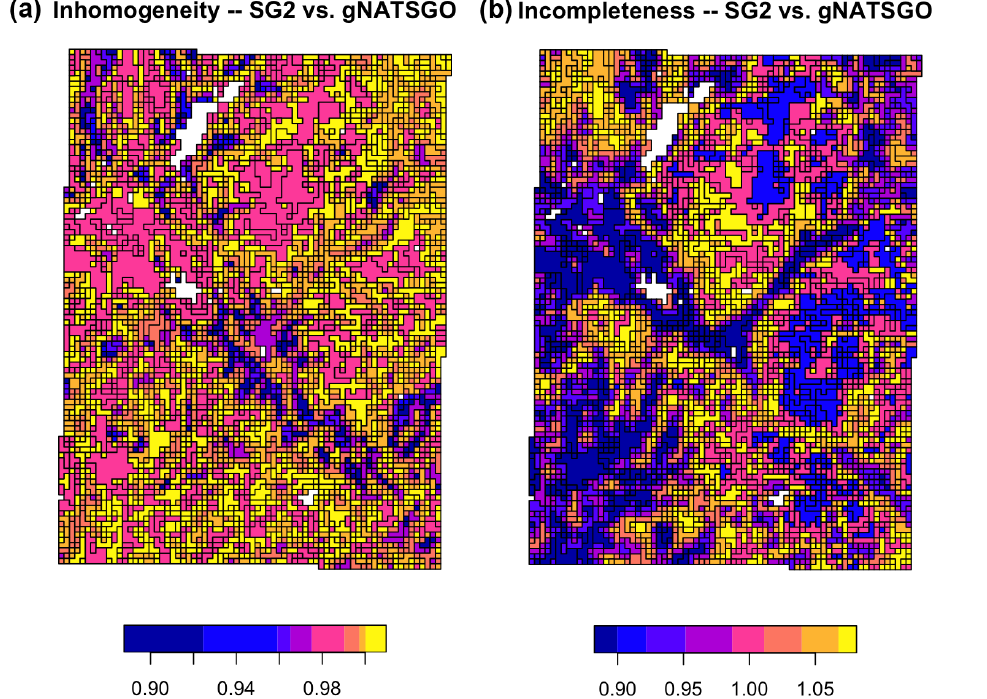
Figure 16. Homogeneity (a) and completeness (b) measures of the SG2 pH class map, with respect to the reference gNATSGO pH class map, at 0–5cm. The values are the inhomogeneity of each zone (a) and the incompleteness of each region (b) .